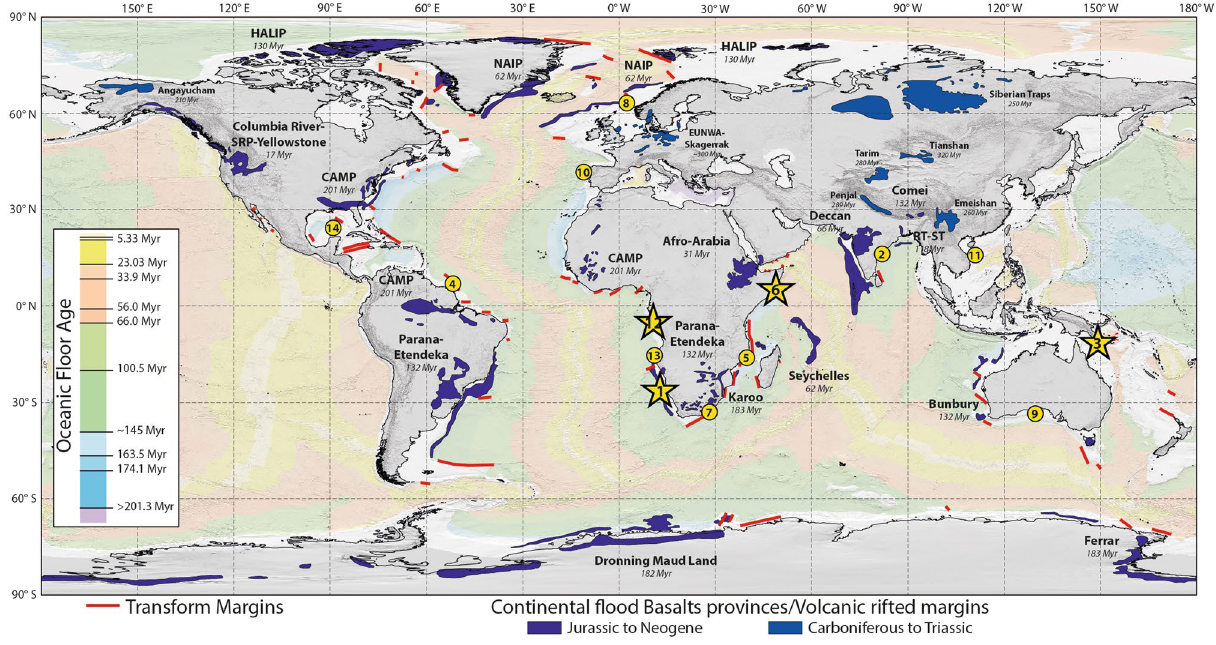
Figure 2. Location of the examples and case studies. The examples shown in Fig. 1 are located on the world map with the oceanic floor age from Müller et al. 133 . The main case studies are emphasized with stars. The main transform margins 134 and continental flood basalts provinces/volcanic rifted margins ( modified from Bryan and Ferrari 135 ) are also